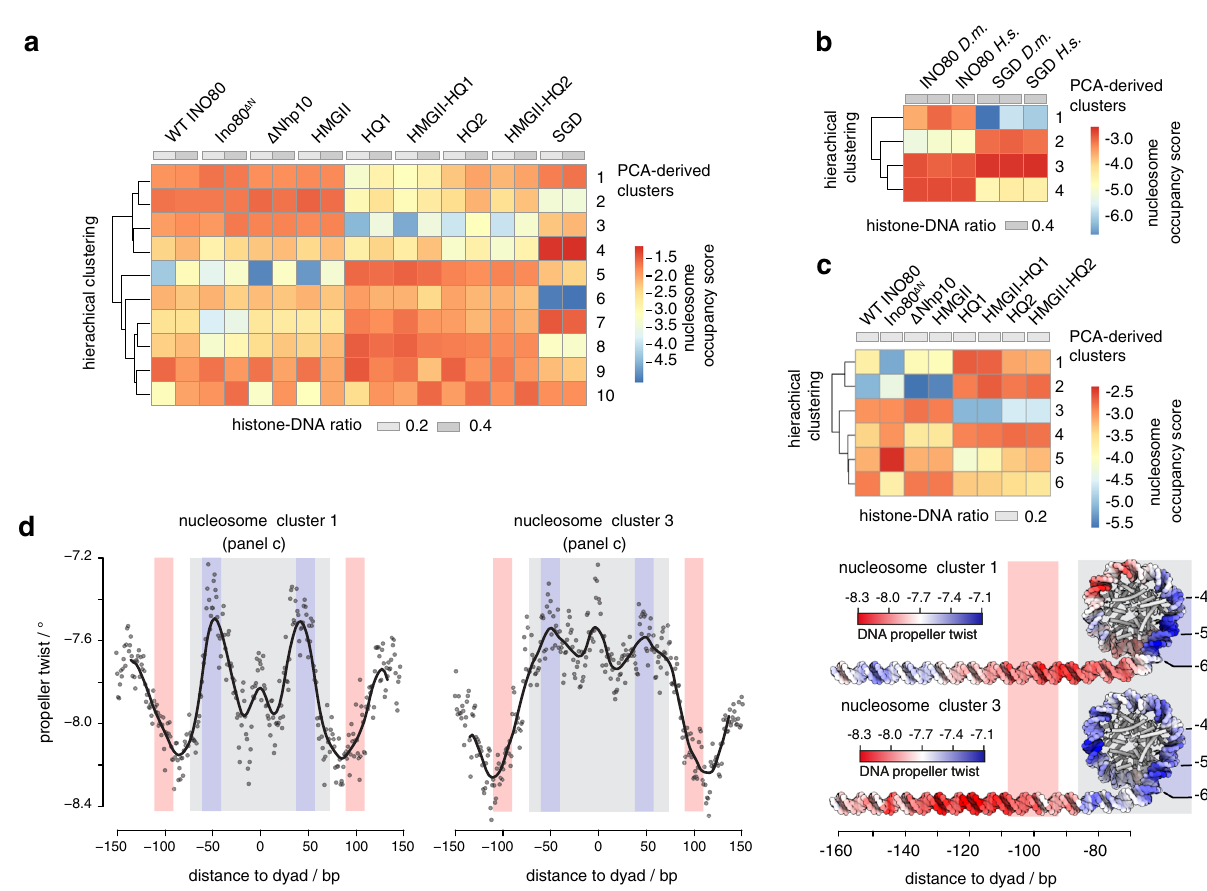
Fig. 5 Structure-based mutations probe the DNA shape/mechanics readout by INO80. a Heat map representation of PCA/clustering analysis as in Fig. 3b, but not row scaled and for SGD chromatin with embryonic D. melanogaster histones at the indicated histone-to-DNA mass ratios either without (SGD) or after remodeling by the indicated recombinant S. cerevisiae WT and mutant INO80 complexes (mutants de fi ned in Fig. 2c; for paired-end sequencing datasets see Supplementary Data 2 and GEO deposition at GSE145093.) b As a but for SGD chromatin with embryonic D. melanogaster ( D.m. ) versus recombinant H. sapiens ( H.s. ) histones and only remodeling by recombinant S. cerevisiae WT INO80 complex (INO80). c As a but only for the indicated subset of samples. d Left: as Fig. 4a but only for nucleosomes from the indicated clusters of c . Right: as in Fig. 4b, propeller twist DNA shape data were mapped onto model of linker and nucleosomal DNA by using red – white – blue color gradient. See Supplementary Fig. 3 for all